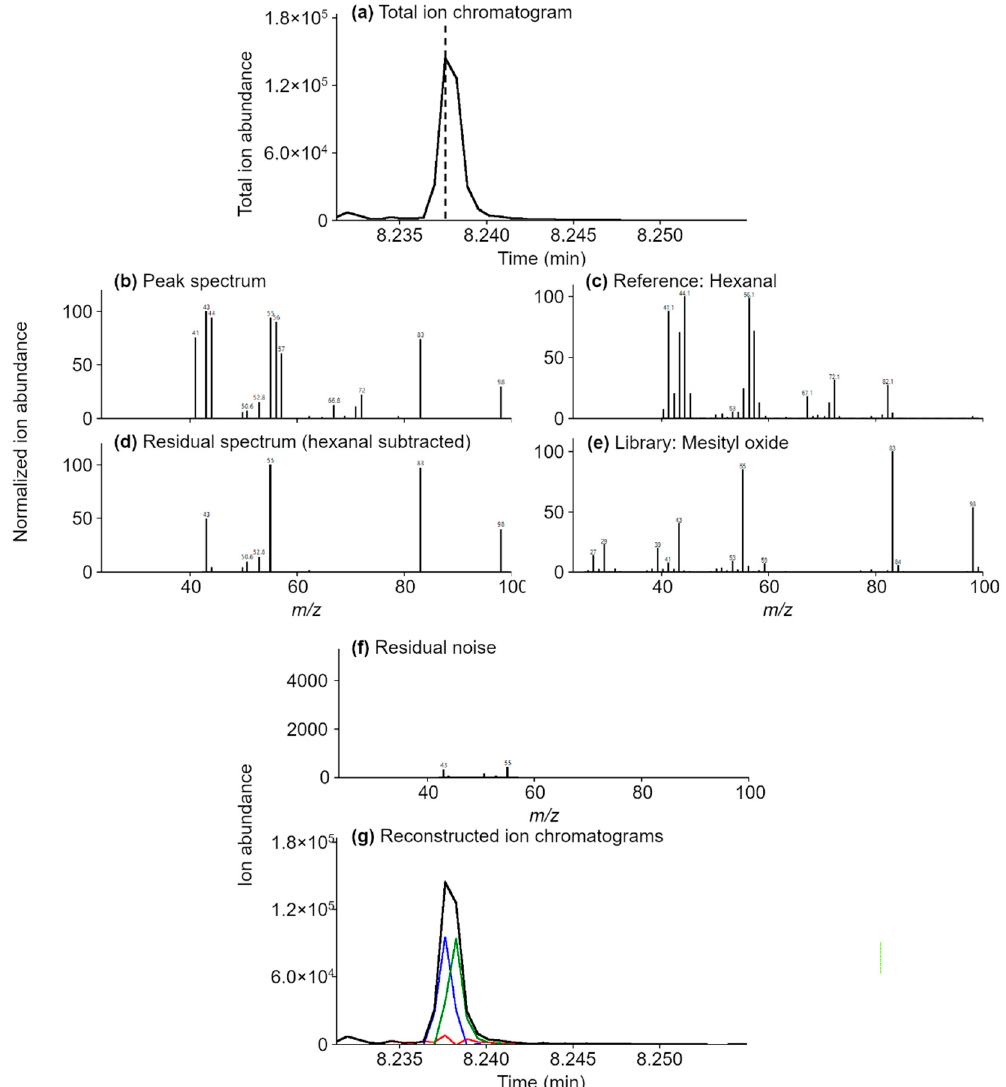
Figure 4. Untargeted analysis example, high elevation tea. Spectral deconvolution and MS subtraction of hexanal, the target compound, ions and relative abundances (c) from the TIC (a) peak spectra (b) yields the residual spectrum (d) for mesityl oxide (e). Subtraction of the ions and relative abundances of both compounds results in baseline noise (f and g). The RIC chromatograms for hexanal (blue) and mesityl oxide (green) are also in (g). Experimental spectra were acquired in the range of 40 – 280 m/z , and therefore, ions below 40 m/z are missing from spectra (b), (c), (d), and (f).